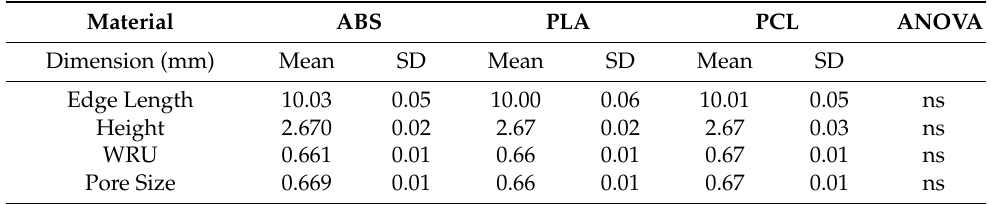
Table 2. Descriptive statistics for the macro- and micro-dimensional accurary of the porous model scaffolds ( n = 9; the significance threshold was set as * p < 0.05, p -value for all statistical test were ns (= not significant)).